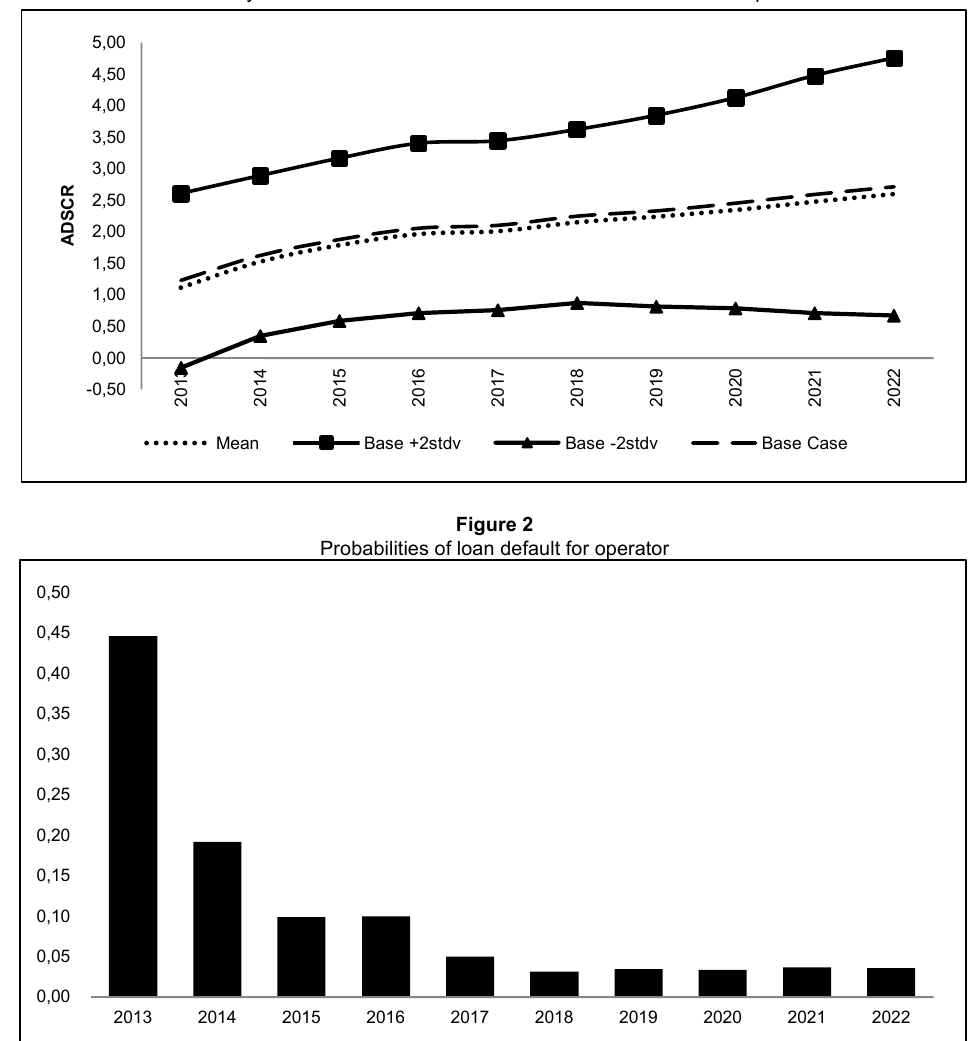
Summary of the statistics for the distributions of ADSCRs for the operator